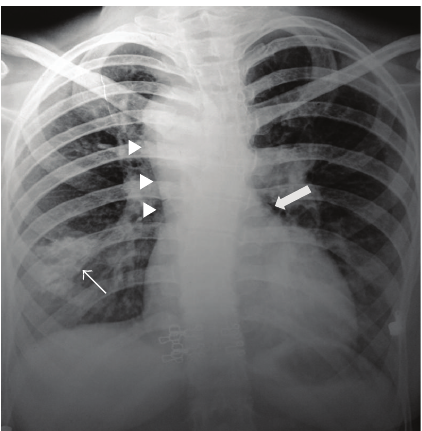
Figure 1: Chest radiograph: frontal view reveals left hilar prominence, right sided aortic arch (arrowheads), absent pulmonary conus (thick arrow), and a small ill-defined calcified nodular radio-opacity in the right lower zone of the lung (thin arrow).